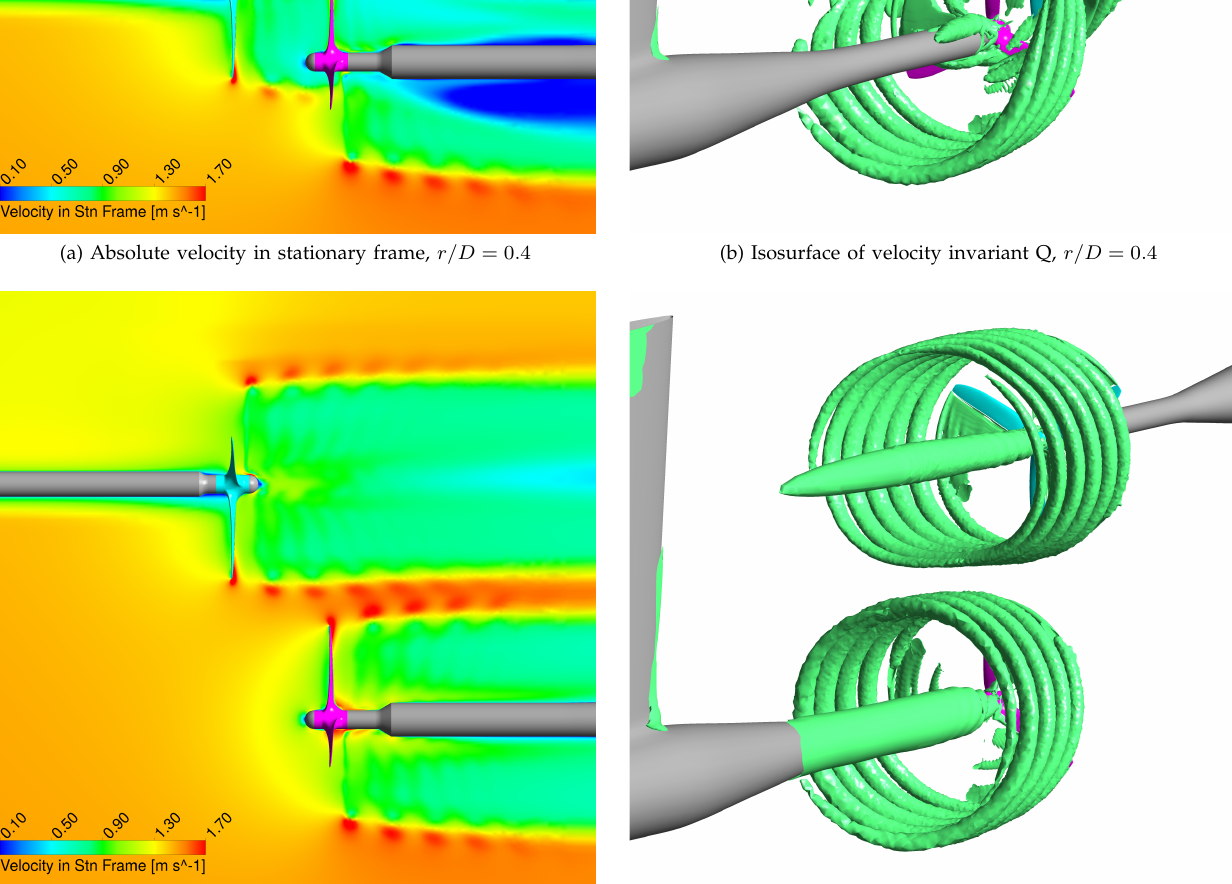
Fig. 14. Simulations for r/D = 0 . 4 and r/D = 1 . 2 . Left: Instantaneous absolute velocity in stationary frame. Right: Isosurface of velocity invariant Q to visualize